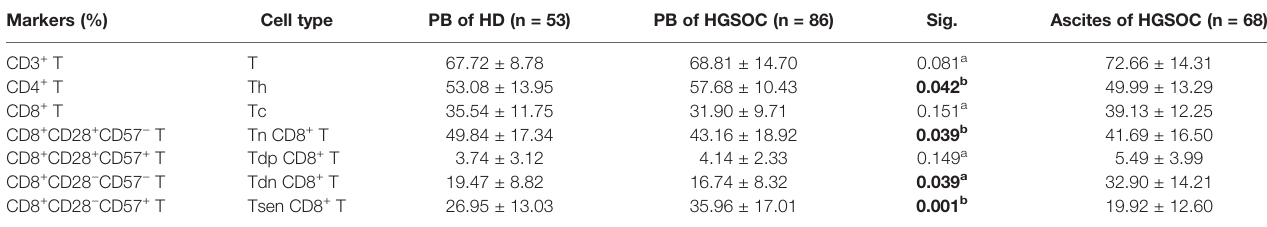
TABLE 2 | Immunophenotyping of major T-cell subsets.